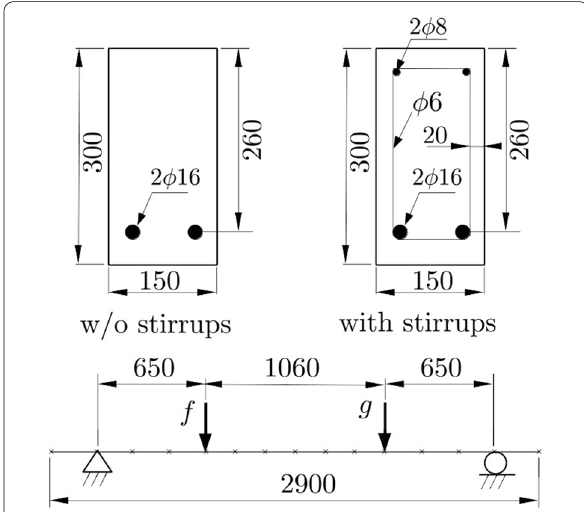
Fig. 9 Cross sections of the beams studied experimentally in Biolzi et al. (2014) together with the imposed boundary conditions in the simulations and the finite element mesh with x marks showing the nodal positions (unit: mm).